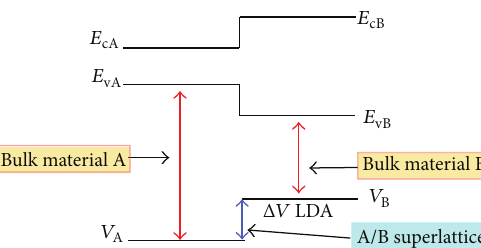
Figure 9: Schematic representation of the model solid approach to compute the valence band-lineup between compounds A and B [42–44]. The band calculations for the bulk materials are combined with a computation of the Δ𝑉 lineup. The conduction band energy levels are represented schematically but not used in the valence band-lineup computation.